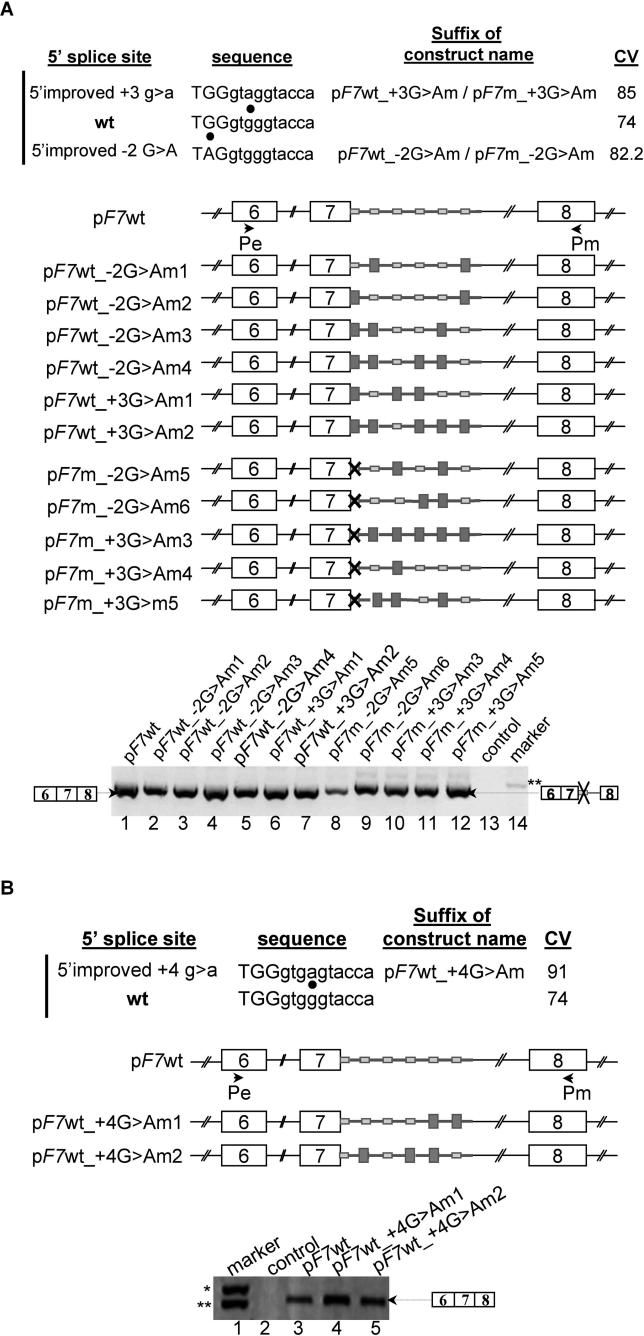
Splicing of a Series of Mutants with Increased Complementarity of the IVS7 5′ Pseudo-Sites to U1snRNA(A) Splicing of F7 transcripts generated from F7 minigenes with a CV of 85 or 82.2.(B) Splicing of F7 transcripts generated from F7 minigenes with a CV of 91.(A and B) Top: Wild-type (middle line in [A], lower line in [B]) and mutated (lower and upper lines in [A], upper line in [B]) 5′ pseudo-sites in the F7 minigene. Dots show the location of the introduced mutations. Suffixes of the constructs' names and the resulting CVs are indicated. Middle: Schematic representation of the constructs transfected in CHO cells. Improved splice sites are represented by a hatched square (see legend to Figure 2A for the meaning of each symbol). Bottom: RT-PCR amplification of F7 transcripts isolated from CHO cells transfected with the above-mentioned constructs. The products corresponding to the different PCR fragments, as identified by sequencing, are schematically represented on both sides of the figure.